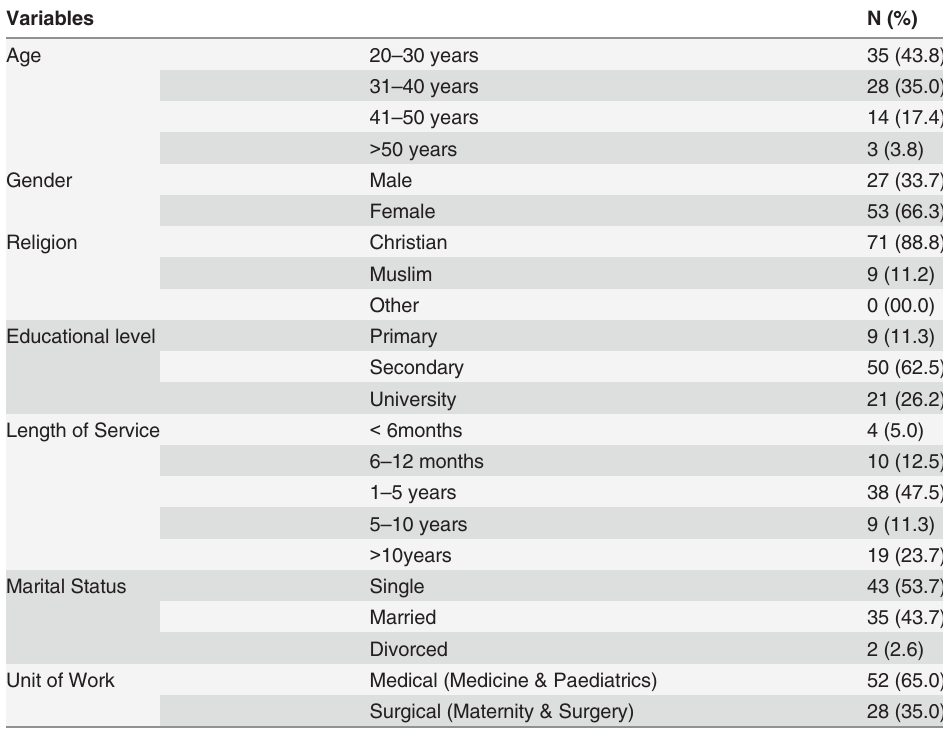
Table 1. Socio-Demographic Characteristics of Nurses in Tubah Health District, 2013. Variables N